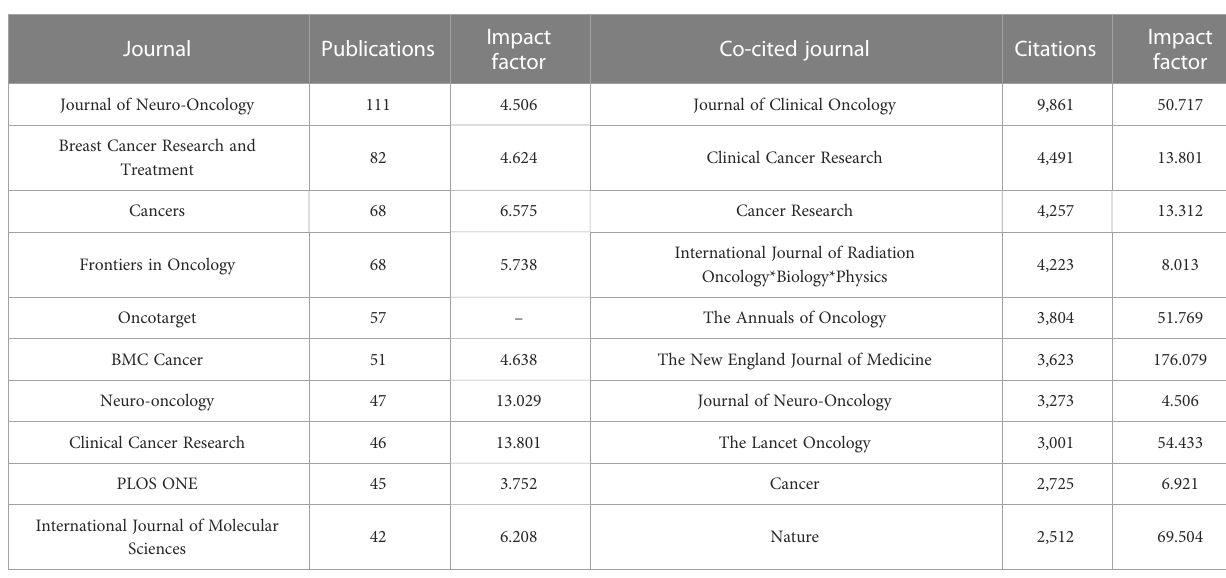
TABLE 3 10 most productive and most cited